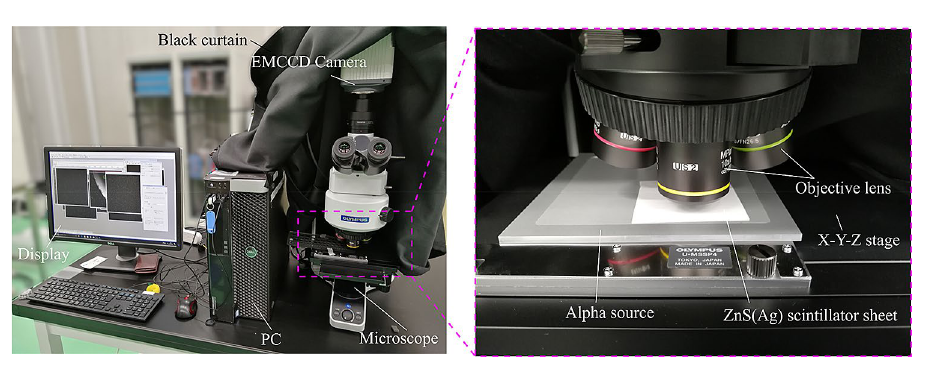
Figure 9. The developed alpha